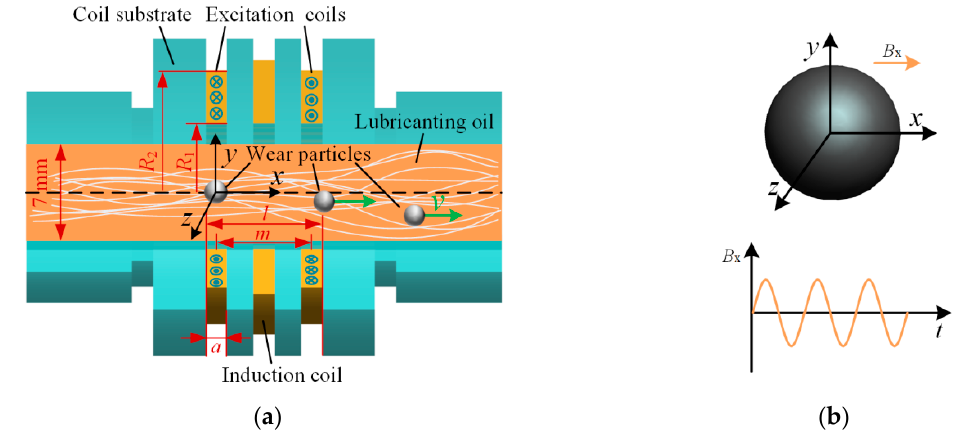
Figure 1. ( a ) The structure of the particle detection sensor; ( b ) The model of wear particle in the